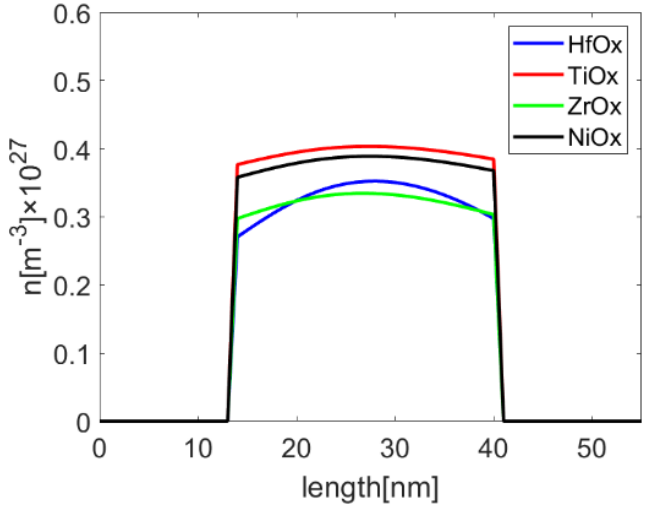
Figure 9. Oxygen vacancy density profiles along the center of inactive cell in Pt-RRAM. Both top and bottom cells are active, and captured under the condition of reset voltages.